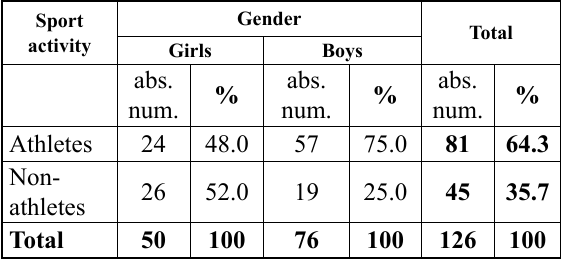
Table 1. Distribution of adolescents by sport activity and gender Sport